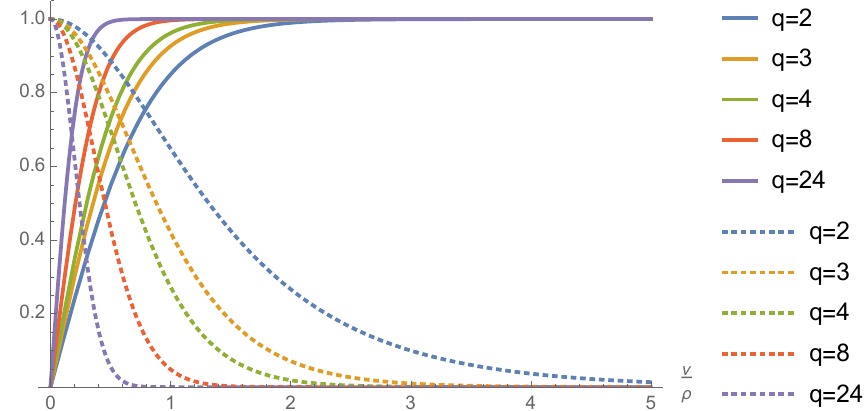
= 1 10 (cid:0) 6 and (cid:2) (cid:3)